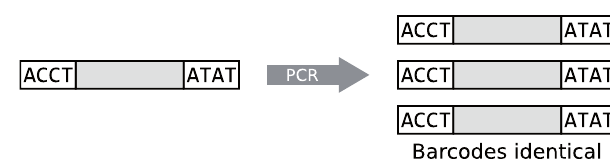
Table 2. Results of analysing HiCUP-processed CHi-C data with CHiCAGO. The table shows the number of statistically significant interactions identified in each of the datasets when duplicate di-tags are retained (Dups) or removed (No dups). The percentage of unique di-tags in each dataset is also shown. (*Unique corresponds to the percentage of di-tags retained after removing all but one representative copy of each